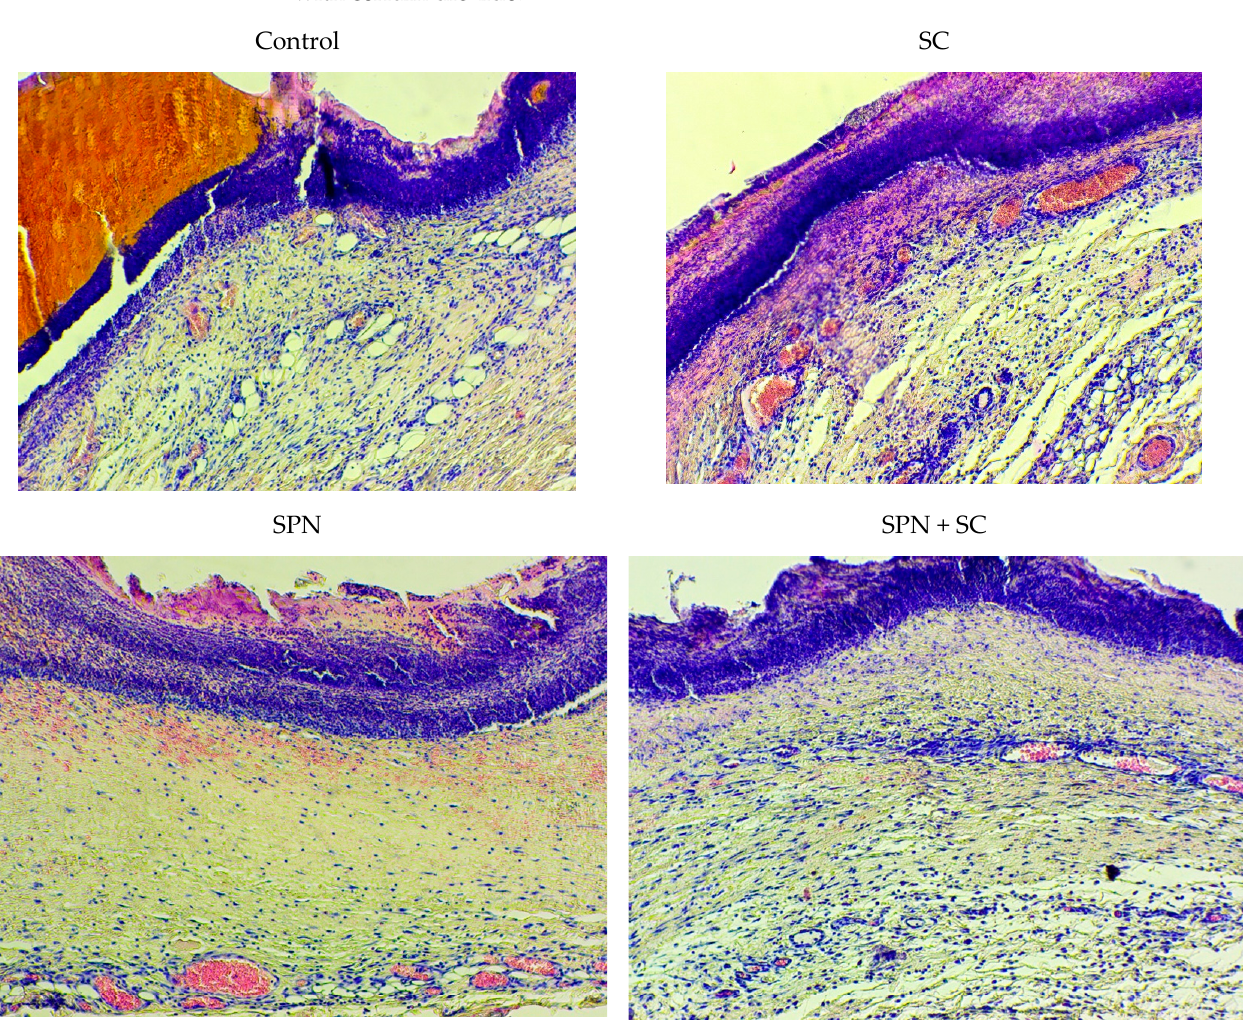
Figure 10. Center of wounds in different groups on the third day of the study (staining with Hematoxylin–Eosin, magnification ×100). Table 2. The content of resident and non-resident cells in the center and edges of wounds of different groups on day 7 (%). Residents on Day